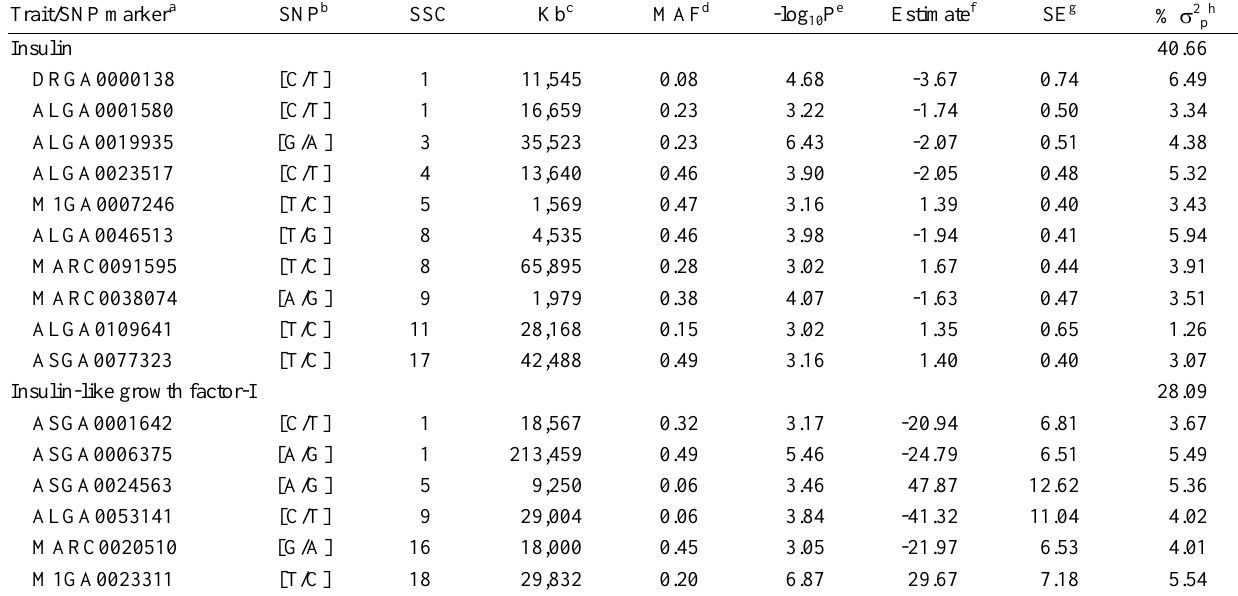
Table 3. Identities, positions, and effects of the SNPs associated with blood component traits in a KNP  YK cross